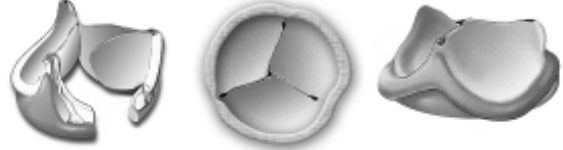
Fig. 1 – Bioprótese “Less